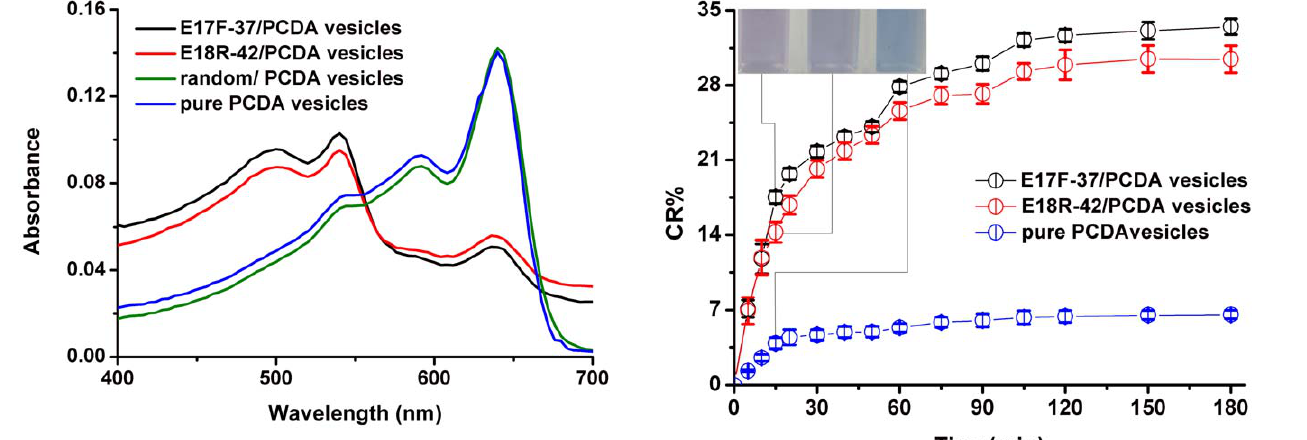
Figure 4. Representative spectrum for E . coli O157:H7 (10 8 CFU/ ml) in presence of E17F-37/PCDA vesicles (black curve), E18R- 42/PCDA vesicles (red curve), random/PCDA vesicles (green curve) and pure PCDA vesicles (blue curve).